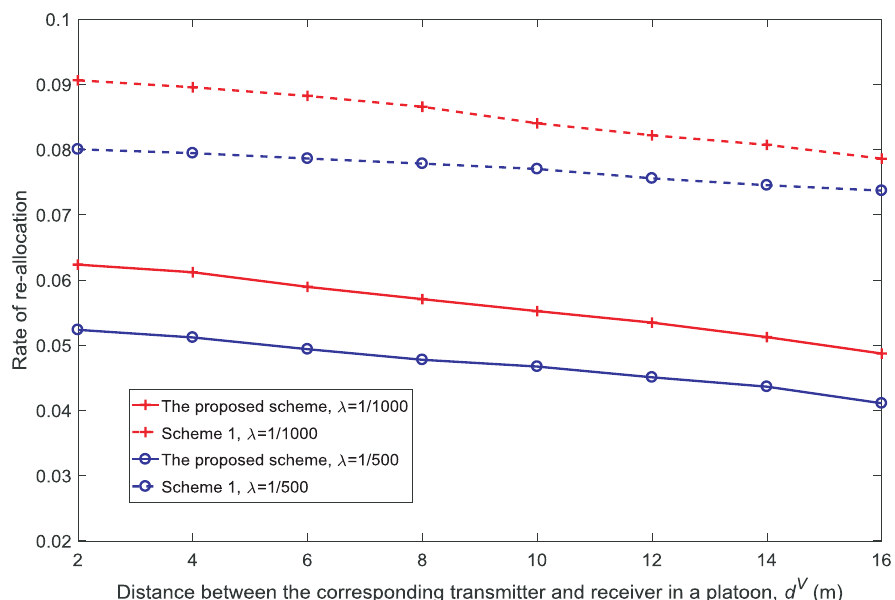
Figure 12. Rate of re-allocation for different distances between the corresponding transmitter and receiver in a platoon d V ( K = 3, V = 10, N = 5 ) .